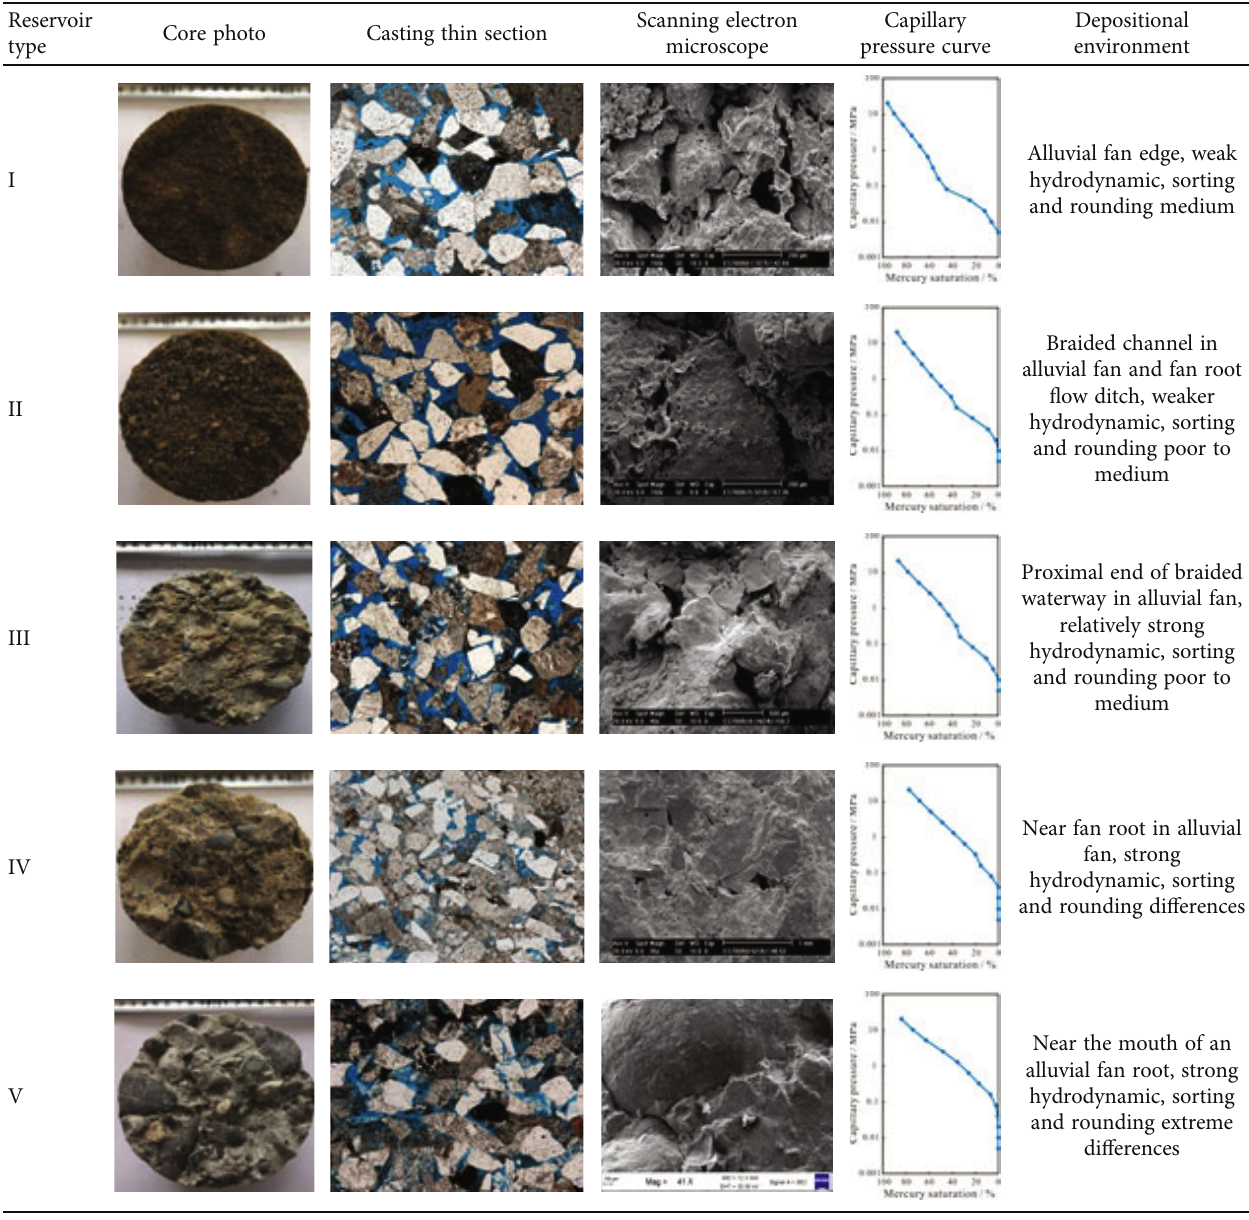
Table 1: Micropore structure classi fi cation characteristics of conglomerate